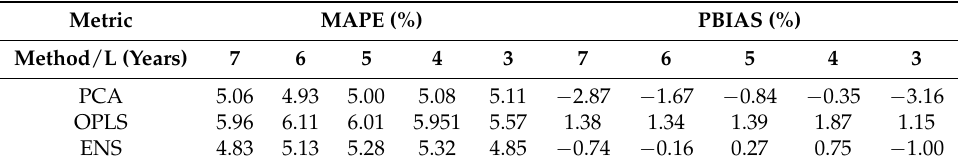
Table 3. Performance in terms of training data size for Hospital Universitario de Fuenlabrada